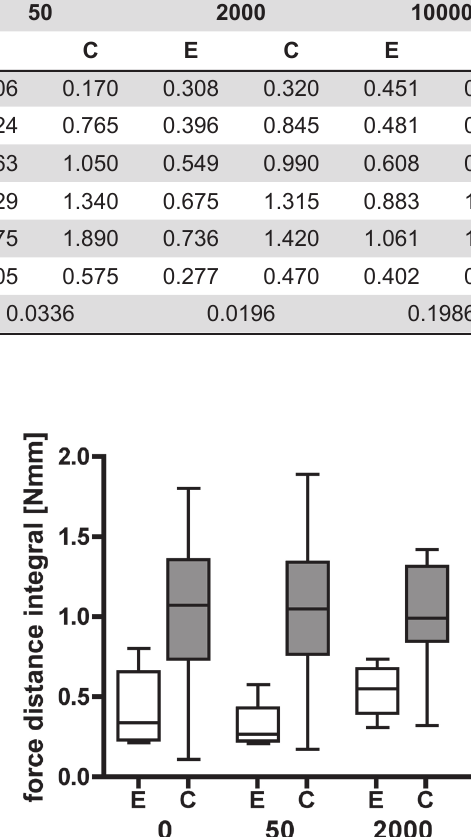
Table 2- Force distance integral [N/mm] at cycle 0, 50, 2,000 and 10,000 - descriptive statistics and p values of the comparison of the median values by the Mann-Whitney-test